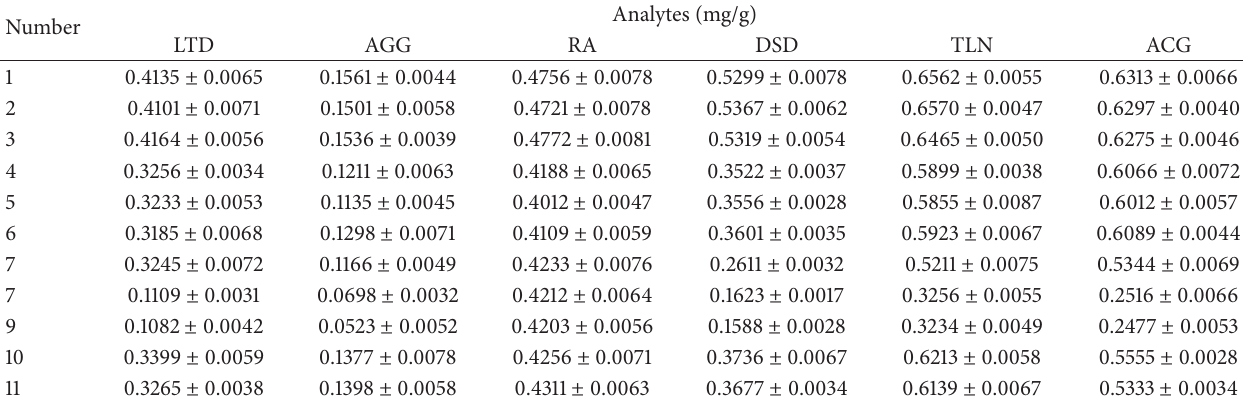
Table 7: Contents of the six analytes in Yixin Badiranjibuya Granules from different manufacturers in China (mean ± SD, 𝑛 = 3 ).